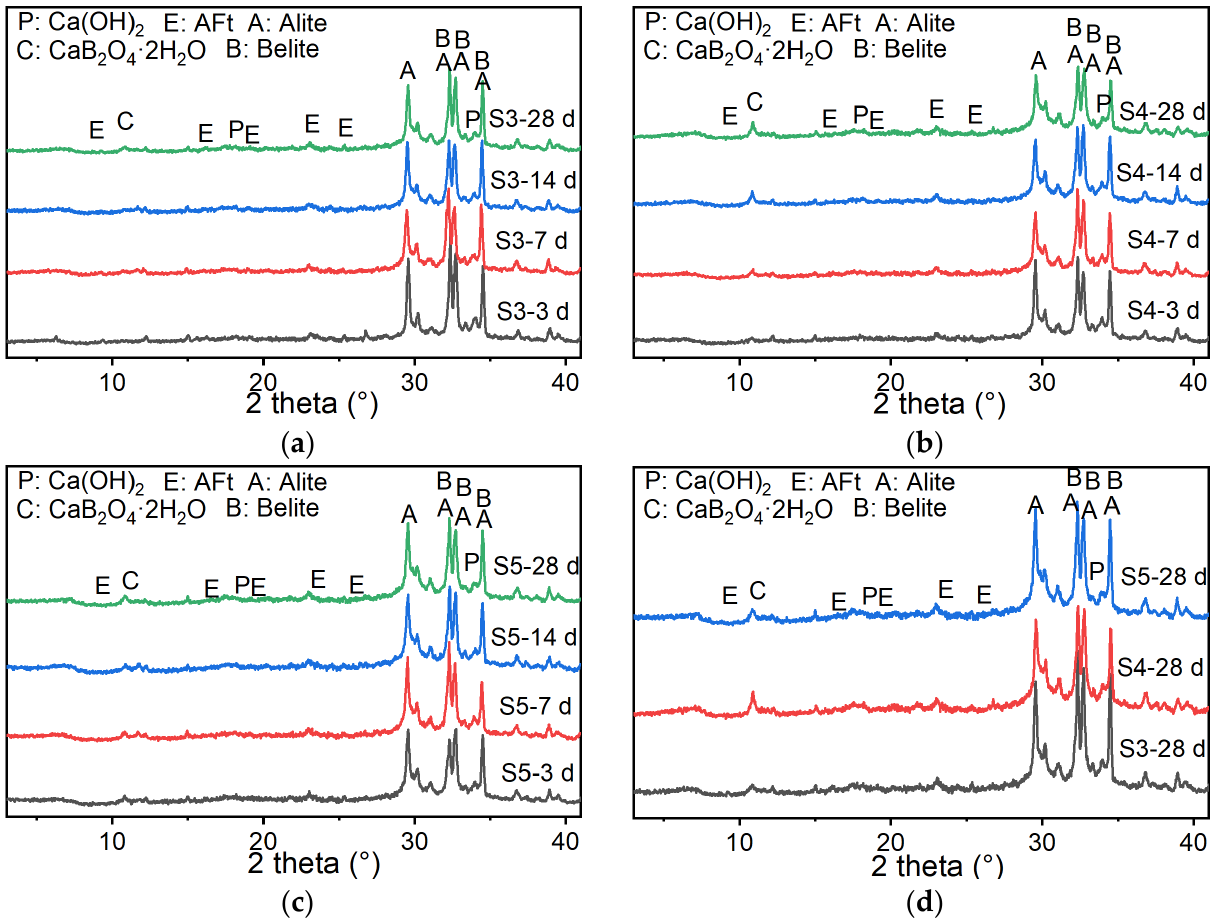
Figure 3. X-ray diffraction (XRD) patterns at different ages for samples ( a ) S3, ( b ) S4, and ( c ) S5, and ( d ) those of different samples at 28 days.